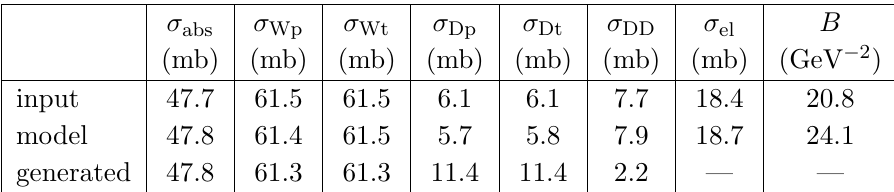
| | Table 1 . Fitting the values of input cross sections for pp collisions at p s = 5 TeV and us- ing the resulting (cid:13)uctuations in a generation and di(cid:11)erent collision types. B is the elastic slope d log (cid:27) el =dt . The cross sections used as \input" were taken from the default parameterisation (cid:0) j t =0 in P YTHIA 8. The line \model" shows the results of a (cid:12)t to the model in eqs. (2.11){(2.13). The line \generated" (cid:12)nally shows the result of the approximation discussed in this subsection and in the appendix. The (cid:12)tting procedure assumed a 5{10% uncertainty on the input values, and